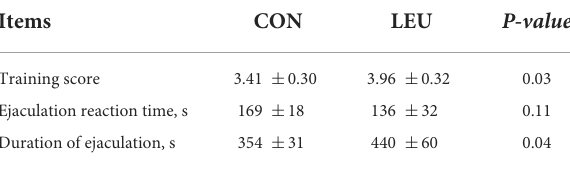
TABLE 4 Effect of dietary leucine supplementation on boar sexual desire.